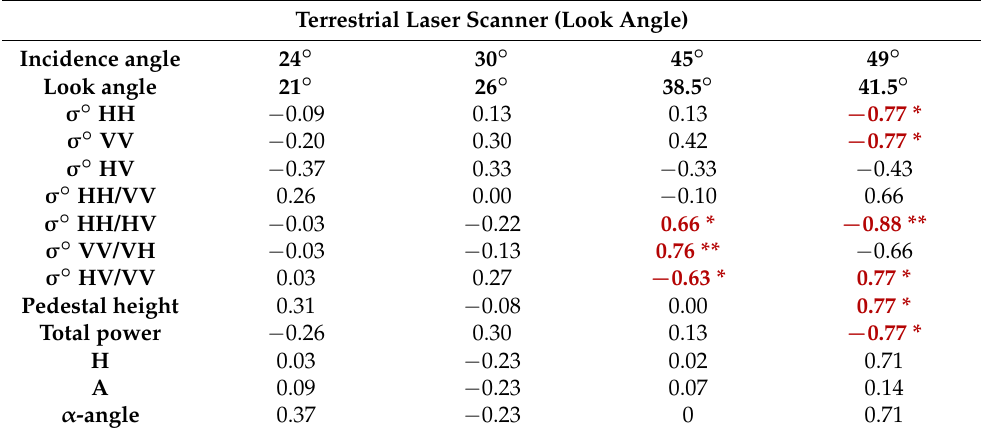
Table 4. The Spearman correlation coefficients ( p value) between averaged polarimetric variables and mean RMSH obtained by TLS at the look